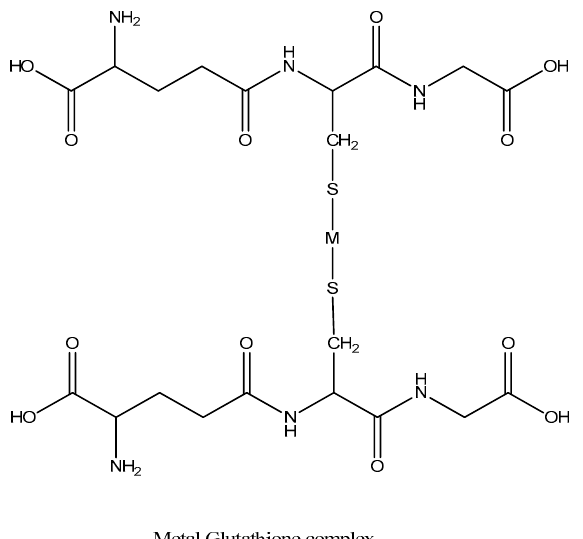
Scheme 2. Chemical structure of metal glutathione complex (Hajrat et al., 2019) [15]. “Re- printed/adapted with permission from Ref. [15]. 2022,